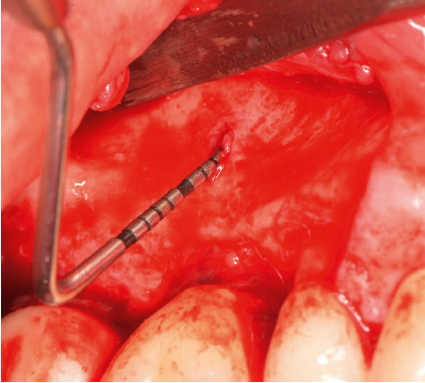
Figure 14: Following reflection of full thickness mucoperiosteal flap, a fenestration of 2 × 2mm width and 7mm depth was revealed.